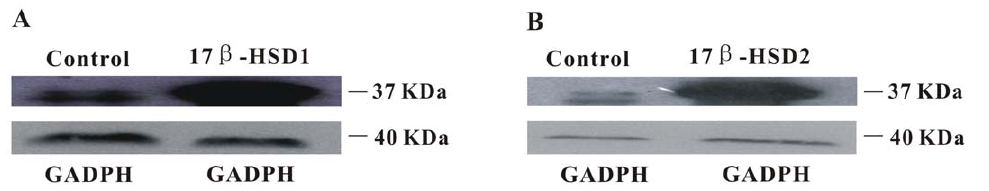
Figure 4. Western blots of 17 b -HSD1 (A) and 17 b -HSD2 (B) with over expressing in MCF-7. 100,000 cells were seeded onto 6-well plates, the cells were transfected with plasmid with over expressing of 17 b -HSD1 and 17 b -HSD2, then western blot was carried out after 48 hours. GADPH was chosen as the internal control protein.